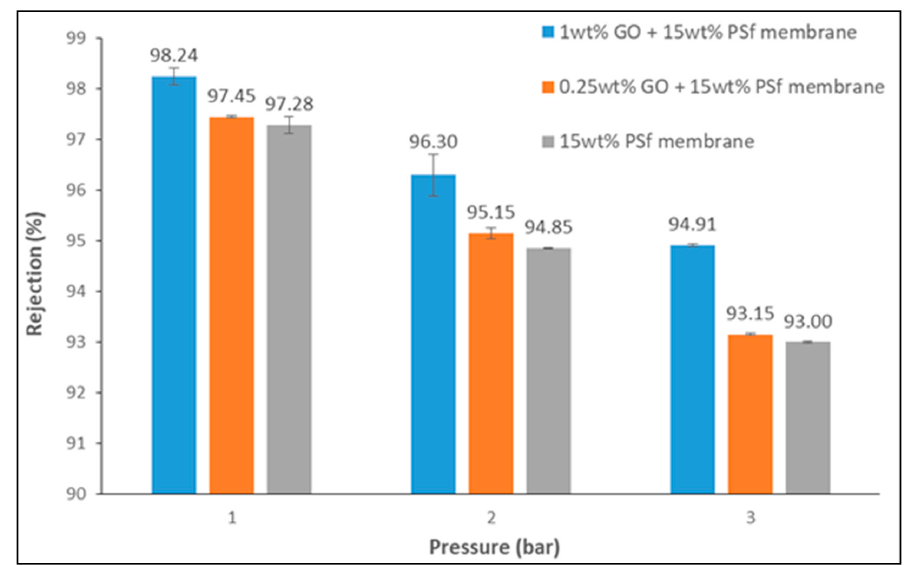
Figure 7. Lead rejection of the membranes at different pressures (lead concentration = 50 mg/L and pH = 5.5) . A maximum lead rejection of 98% was achieved using a 1 wt % GO membrane operated at a pressure of 1 bar. This rejection decreased to 94% at 3 bars. Pristine PSf membrane showed a very high rejection rate of 93% at 3 bars. This high rejection by the pristine PSf membrane may have been due to the presence of smaller pores. The influence of GO could be seen with the increase in rejection, which was not very high but definite.